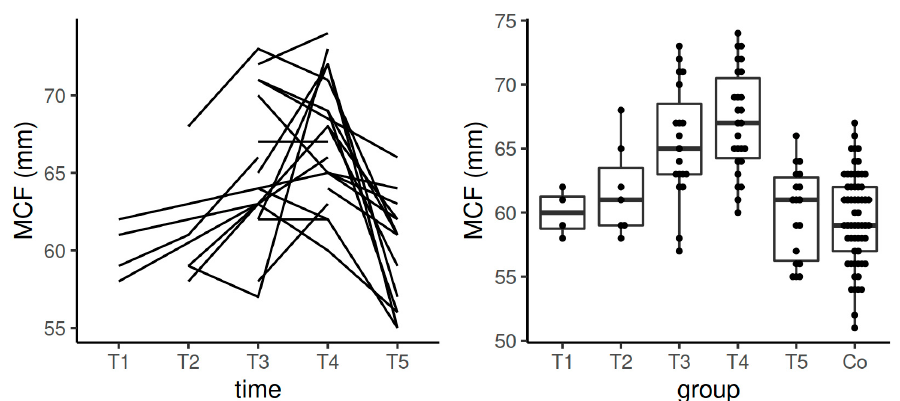
Figure 10. Spaghetti plot of the data from the longitudinal study ( left ) and swarmplot with boxplot of the same data together with the data from the control group ( right )—the results of MCF in HEPTEM. Legend: Co—control group, MCF—maximum clot firmness, T1—time interval 1, T2—time interval 2, T3—time interval 3, T4—time interval 4, T5—time interval 5.